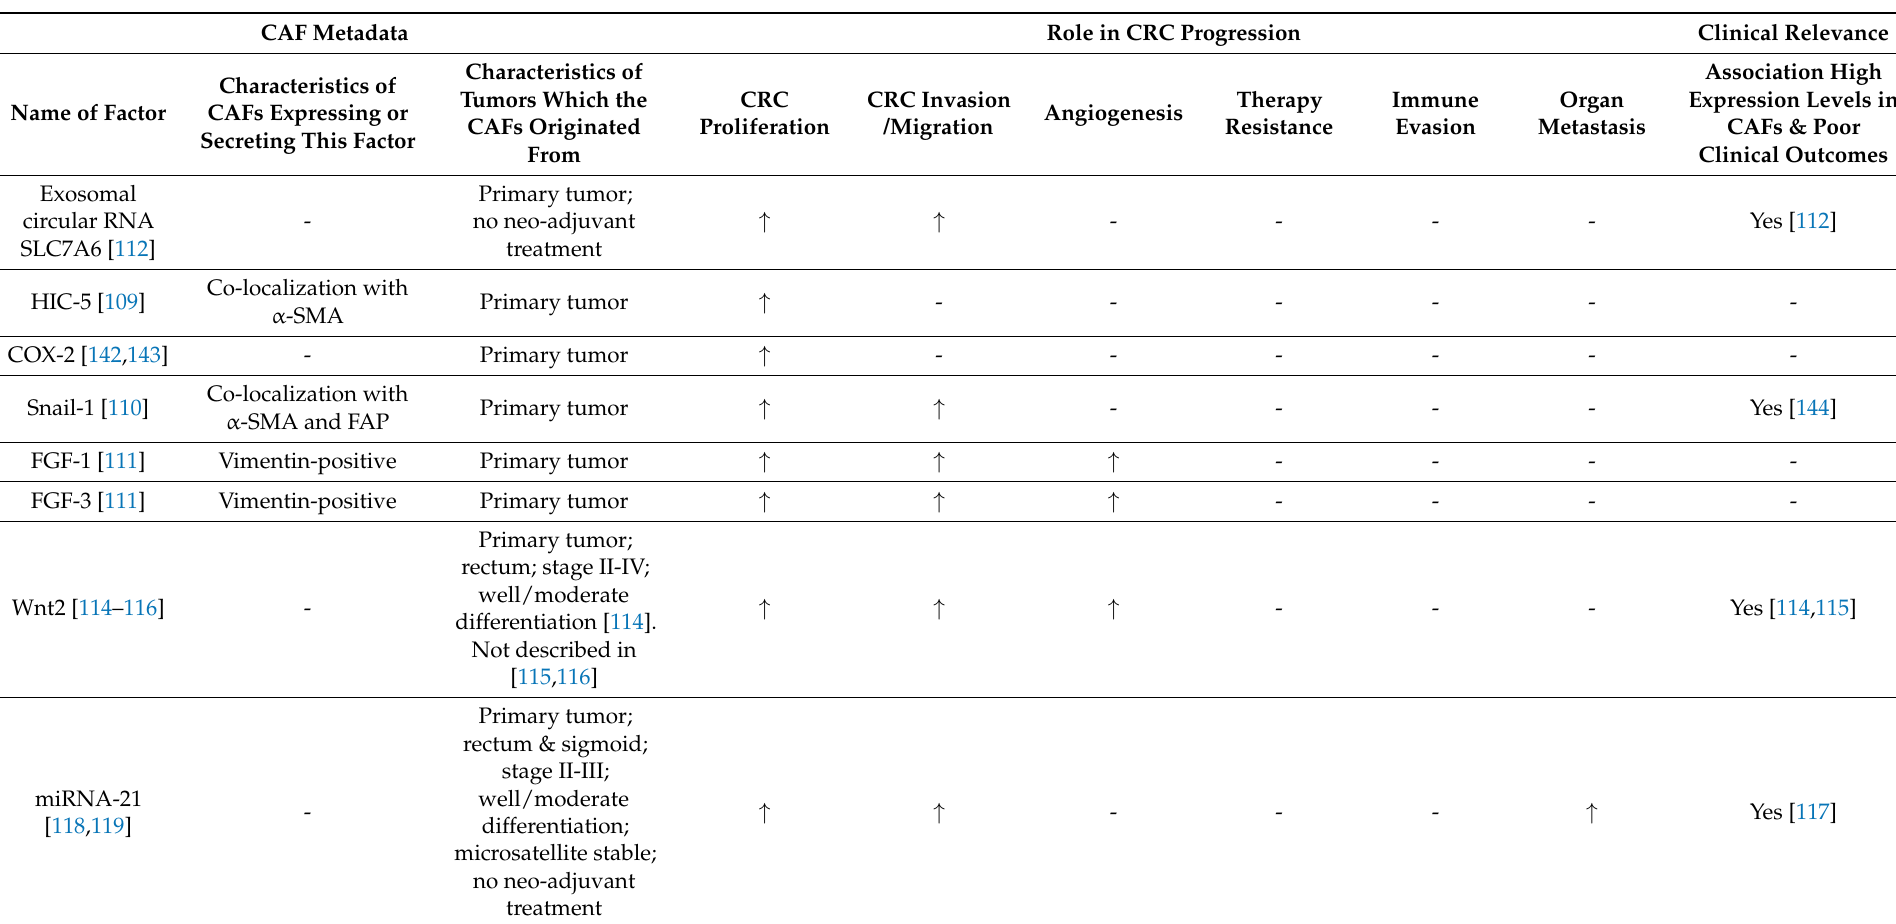
Table 1. Examples of tumor-related functions which have been linked to factors expressed or secreted by certain cancer-associated fibroblast (CAF) populations in human advanced colorectal cancers